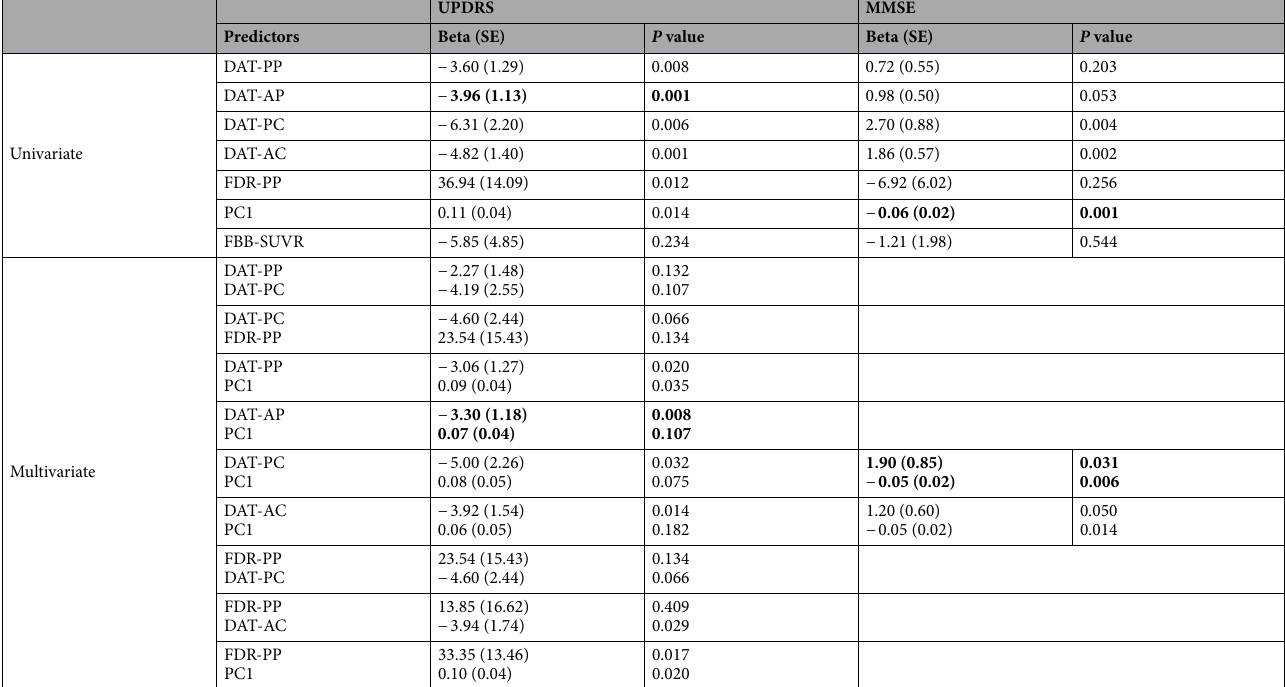
Table 4. Predictors for UPDRS motor and MMSE scores in DLB patients. Results are based on general linear models for UPDRS motor and MMSE scores after controlling for age, sex, education, HTN, DM, DWMH, and PWMH. The model emphasized in bold reflects minimizing AICs. AIC akaike information criterion, DAT dopamine transporter, DAT-AC DAT uptake in the anterior caudate, DAT-AP DAT uptake in the anterior putamen, DAT-PC DAT uptake in the posterior caudate, DAT-PP DAT uptake in the posterior putamen, DLB dementia with Lewy bodies, DM diabetes mellitus, DWMH deep white matter hyperintensities, FBB- SUVR 18 F-Florbetaben standardized uptake value ratio, FDG 18 F-fluorodeoxyglucose uptake, FDR-PP FDG to DAT ratio in the posterior putamen, HTN hypertension, MMSE mini-mental state examination, PC1 the first principal component of FDG subject residual profile, PWMH periventricular WMH, UPDRS unified Parkinson’s disease rating